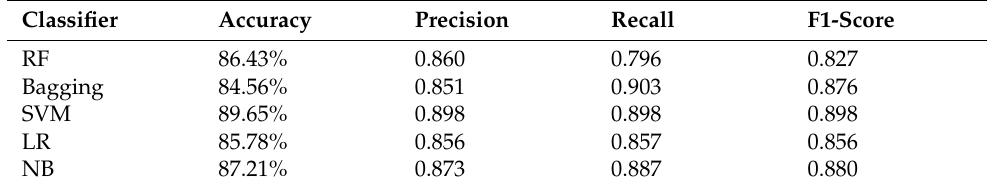
Table 14. Experiments with ML models and BoW on Arab TextBlob sentiments.